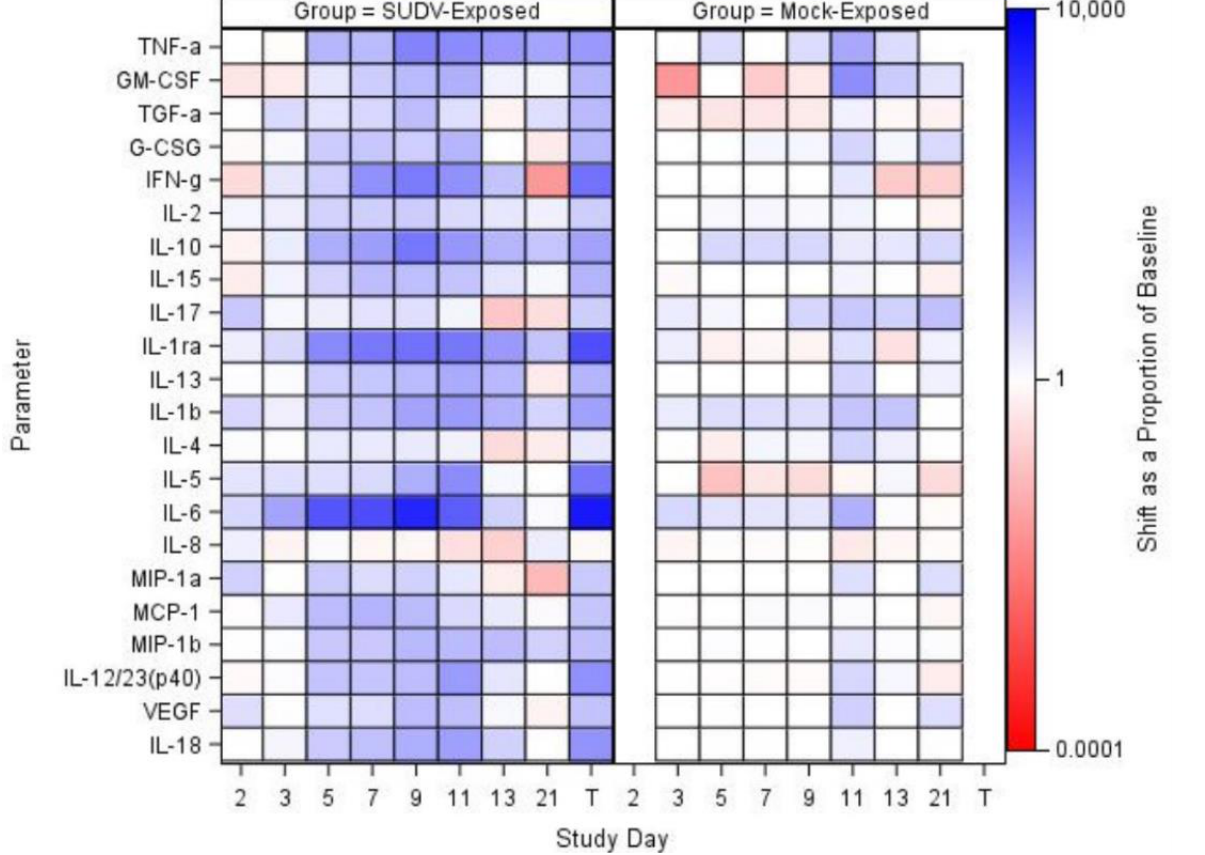
Figure 6. Shift as a proportion of baseline at each study day for biomarkers that were log-transformed for analysis, represented in a heat map; sCD40L was not transformed and was not included in the heatmap. TNF- α data are not available for mock-exposed animals on Day 21. T represents Terminal (data collected from animals that met euthanasia criteria were combined and reported as a single terminal time